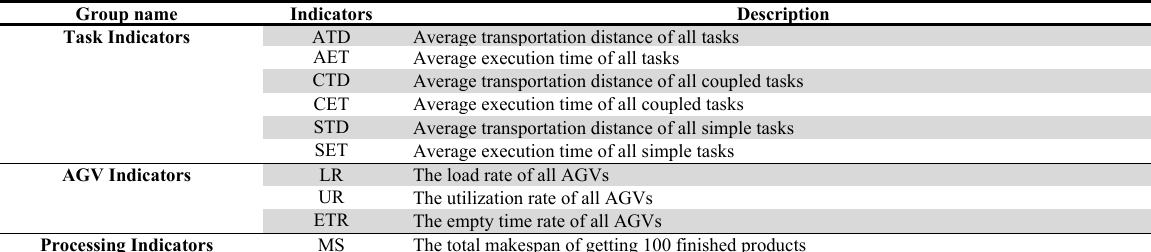
Experiment Indicators Group name Indicators